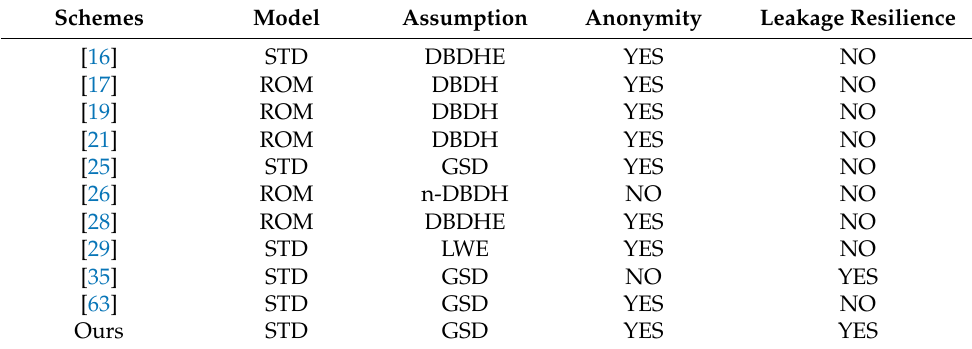
Table 2. Security comparisons of some related